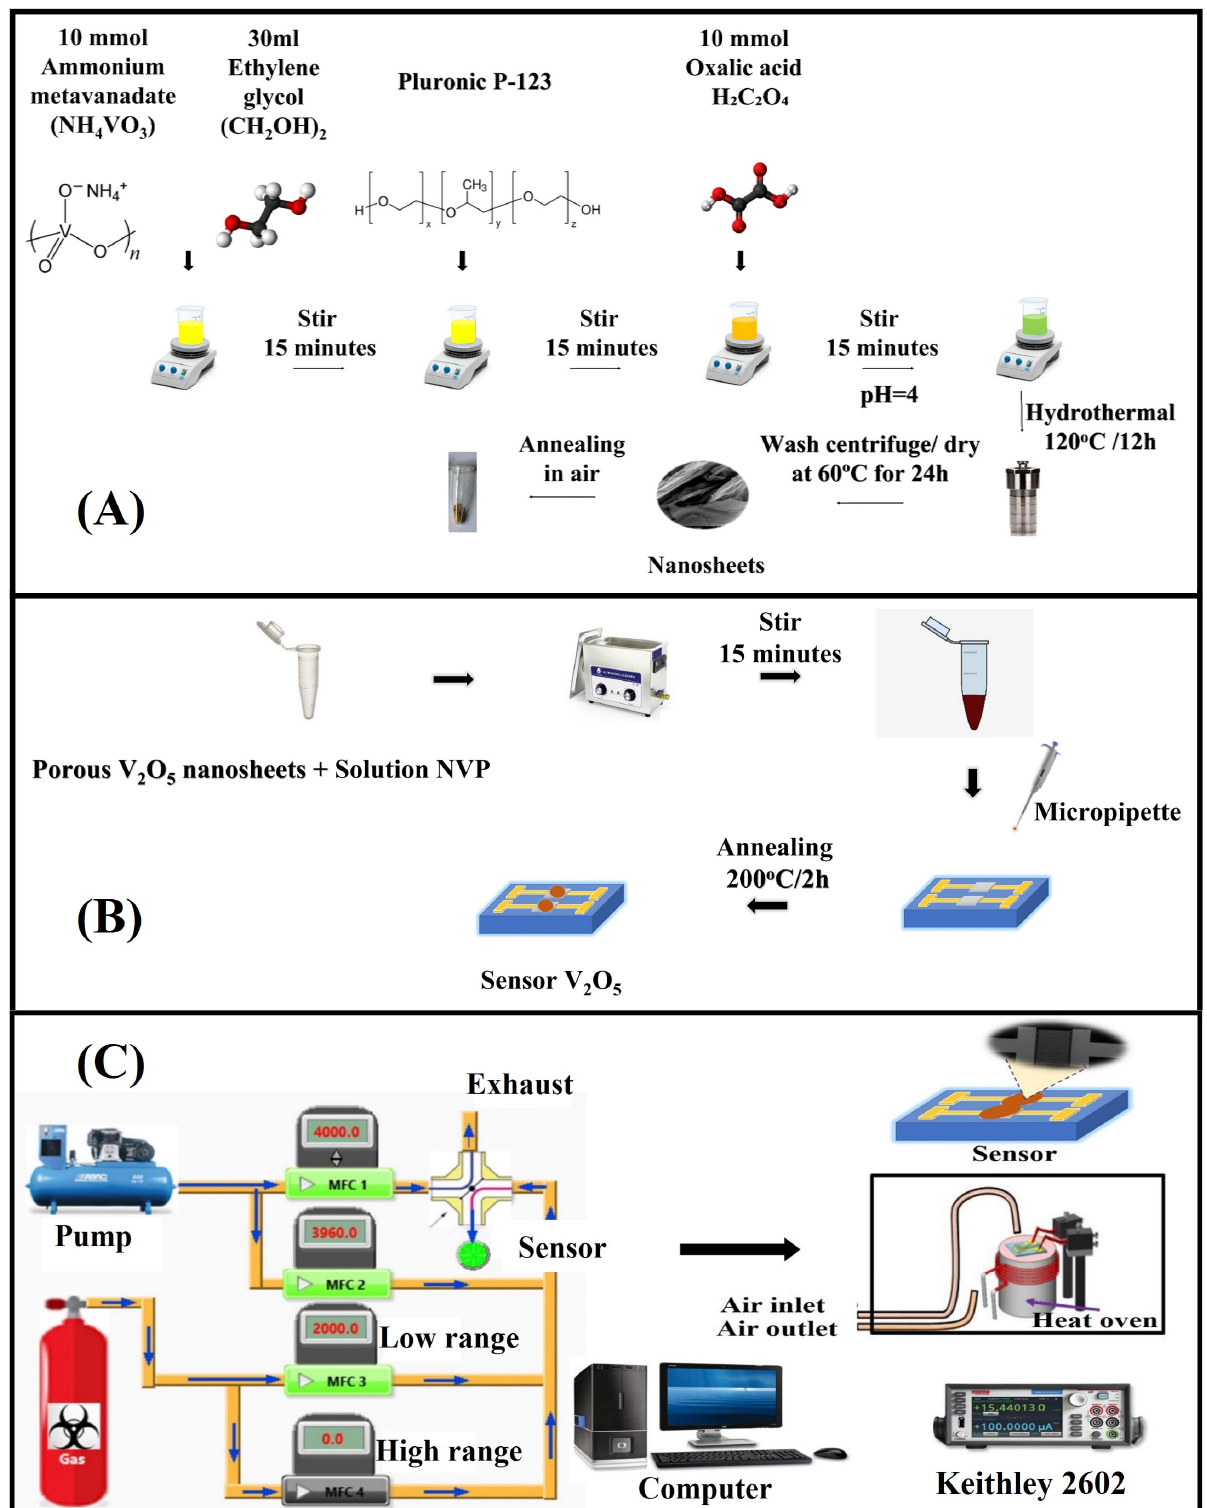
Figure 1. Process diagram of ( A ) hydrothermal synthesis of V 2 O 5 nanosheets, ( B ) drop coating of the nanomaterial on electrodes to make the gas sensor, and ( C ) homemade gas measurement system .